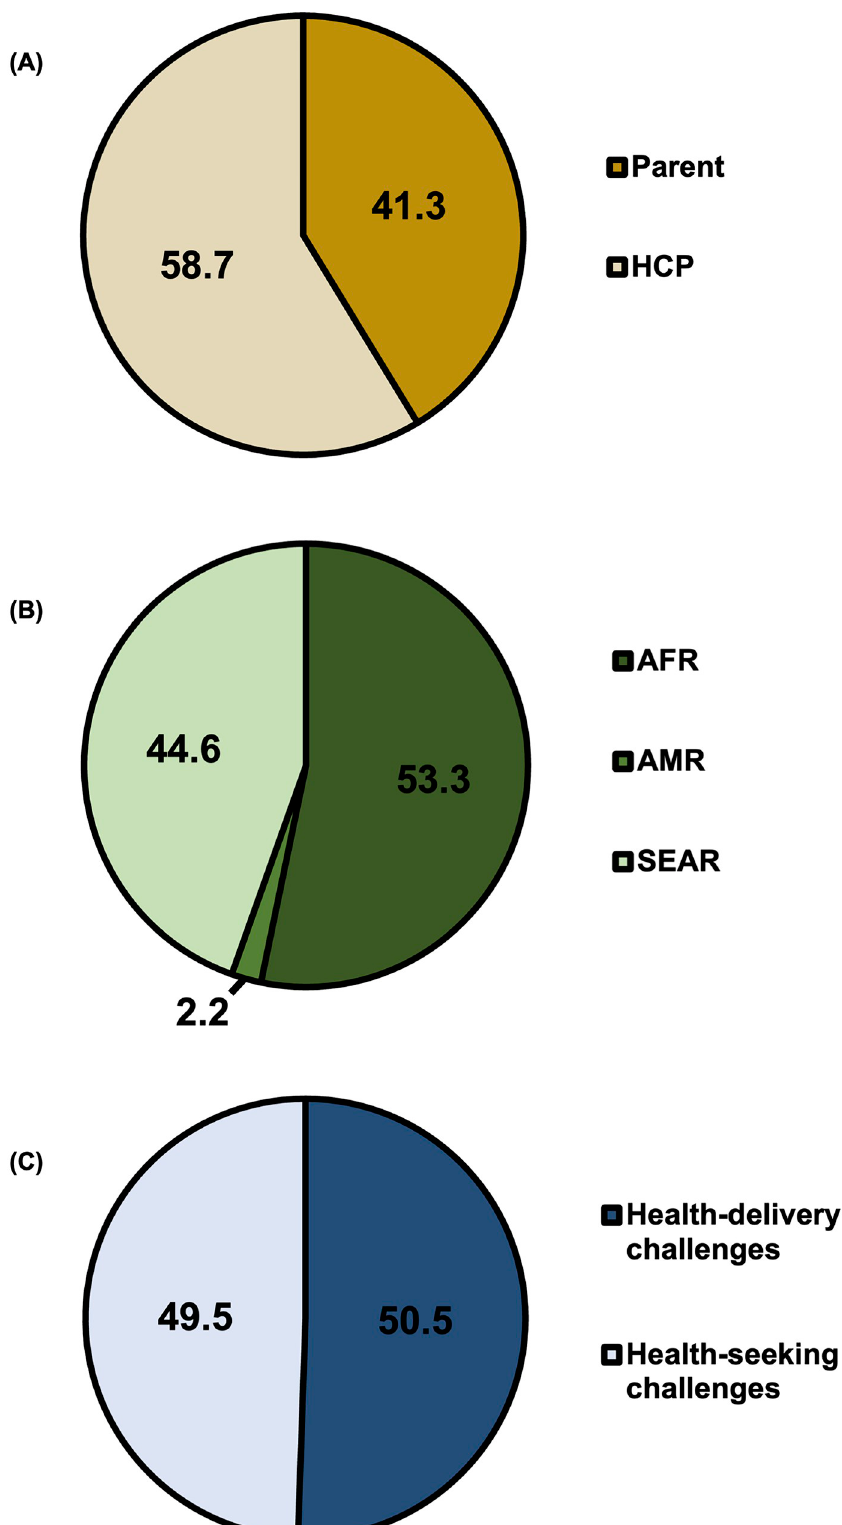
Fig 6. Percentage of total respondents in qualitative studies by actor (A) and by world region (B); n = 92. Percentage of total responses by healthcare-seeking and healthcare-delivery issues (C); n = 597. https://doi.org/10.1371/journal.pgph.0001415.g006 PLOS Global PublicHealth | https://doi.org/10.1371/journal.pgph.0001415 January24,